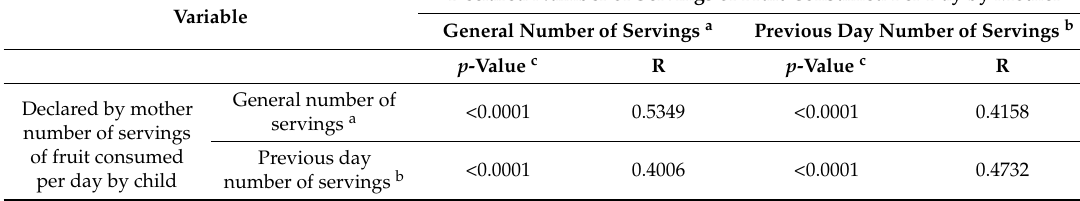
Table 8. Analysis of the correlation between the number of servings of fruit consumed per day by mothers, and their declared consumption by their children in a national sample of Romanian respondents ( n =